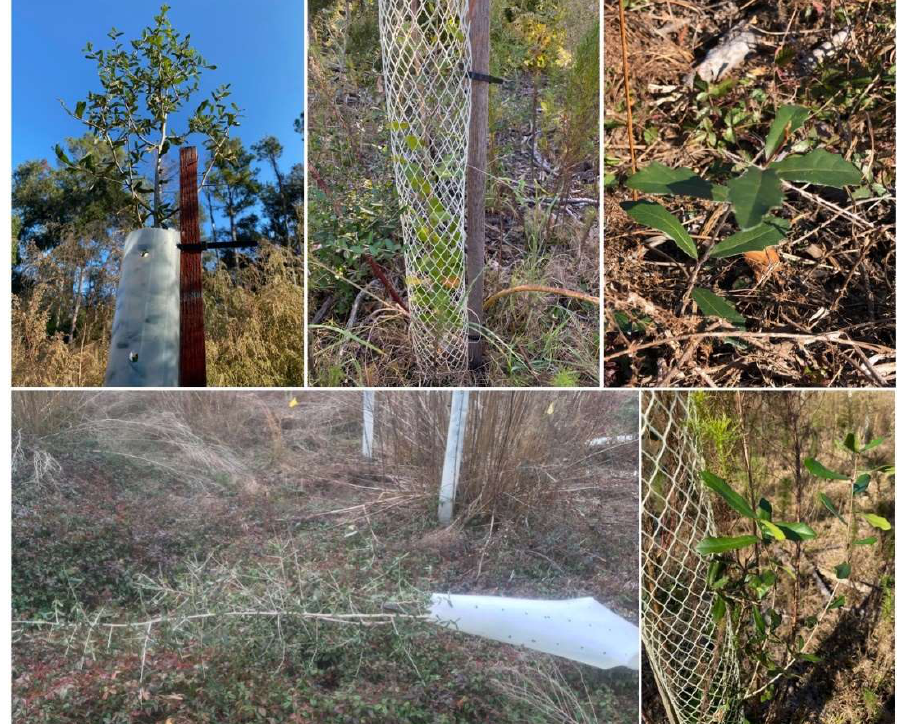
Figure 6. Clockwise from top-left: successful tube shelter after one growing season (photo credit: D. Jacobs), successful mesh shelter after one growing season (photo credit: D. Jacobs), an unsheltered seedling after one growing season (photo credit: D. Jacobs), a fallen tube after two growing seasons (photo credit: C. Redick), a mesh shelter with some branches growing through it after one growing season (photo credit: D. Jacobs).